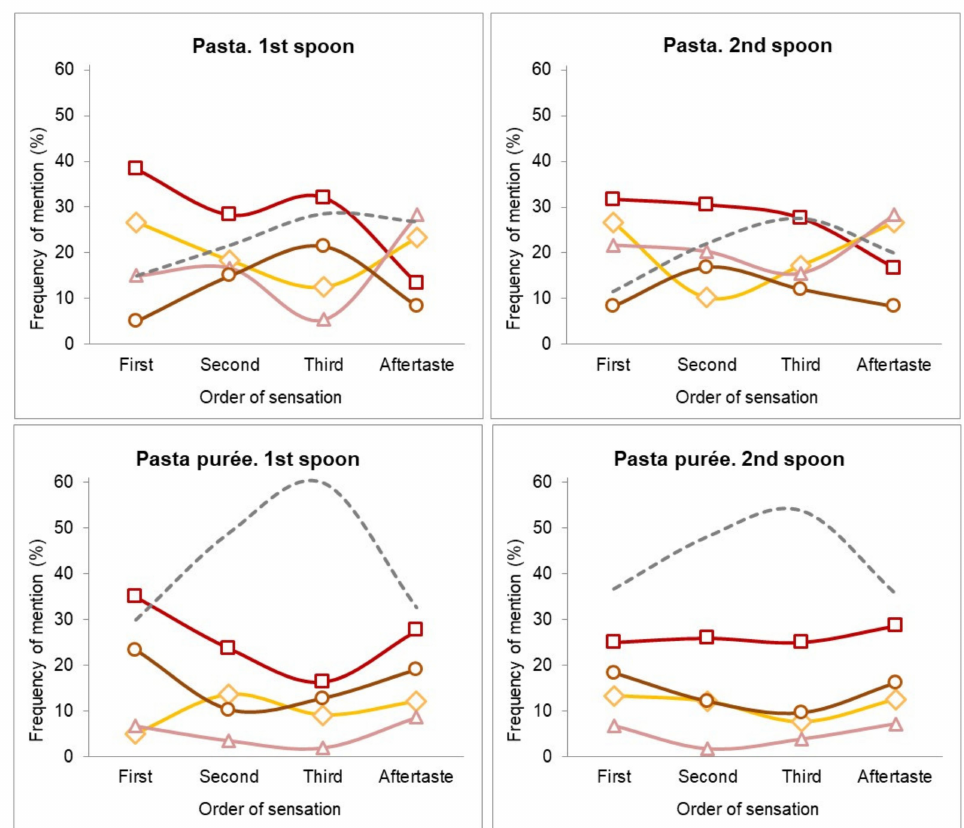
Figure 1. Free-Temporal order of sensation (TOS) plot for the pasta dish and pasta pur é e. Frequency of mention of the main mentioned flavors: tomato ( (cid:3) ); cheese ( ♦ ); dry-cured ham ( ∆ ); meat ( sensations and aftertaste during the first and second